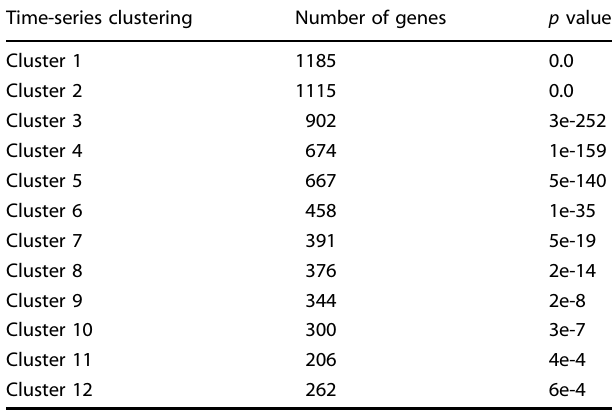
STEM detected 12 signi fi cant gene clusters based on similar gene expression pro fi les across fi ve-time points. The number of genes and p values in each cluster are